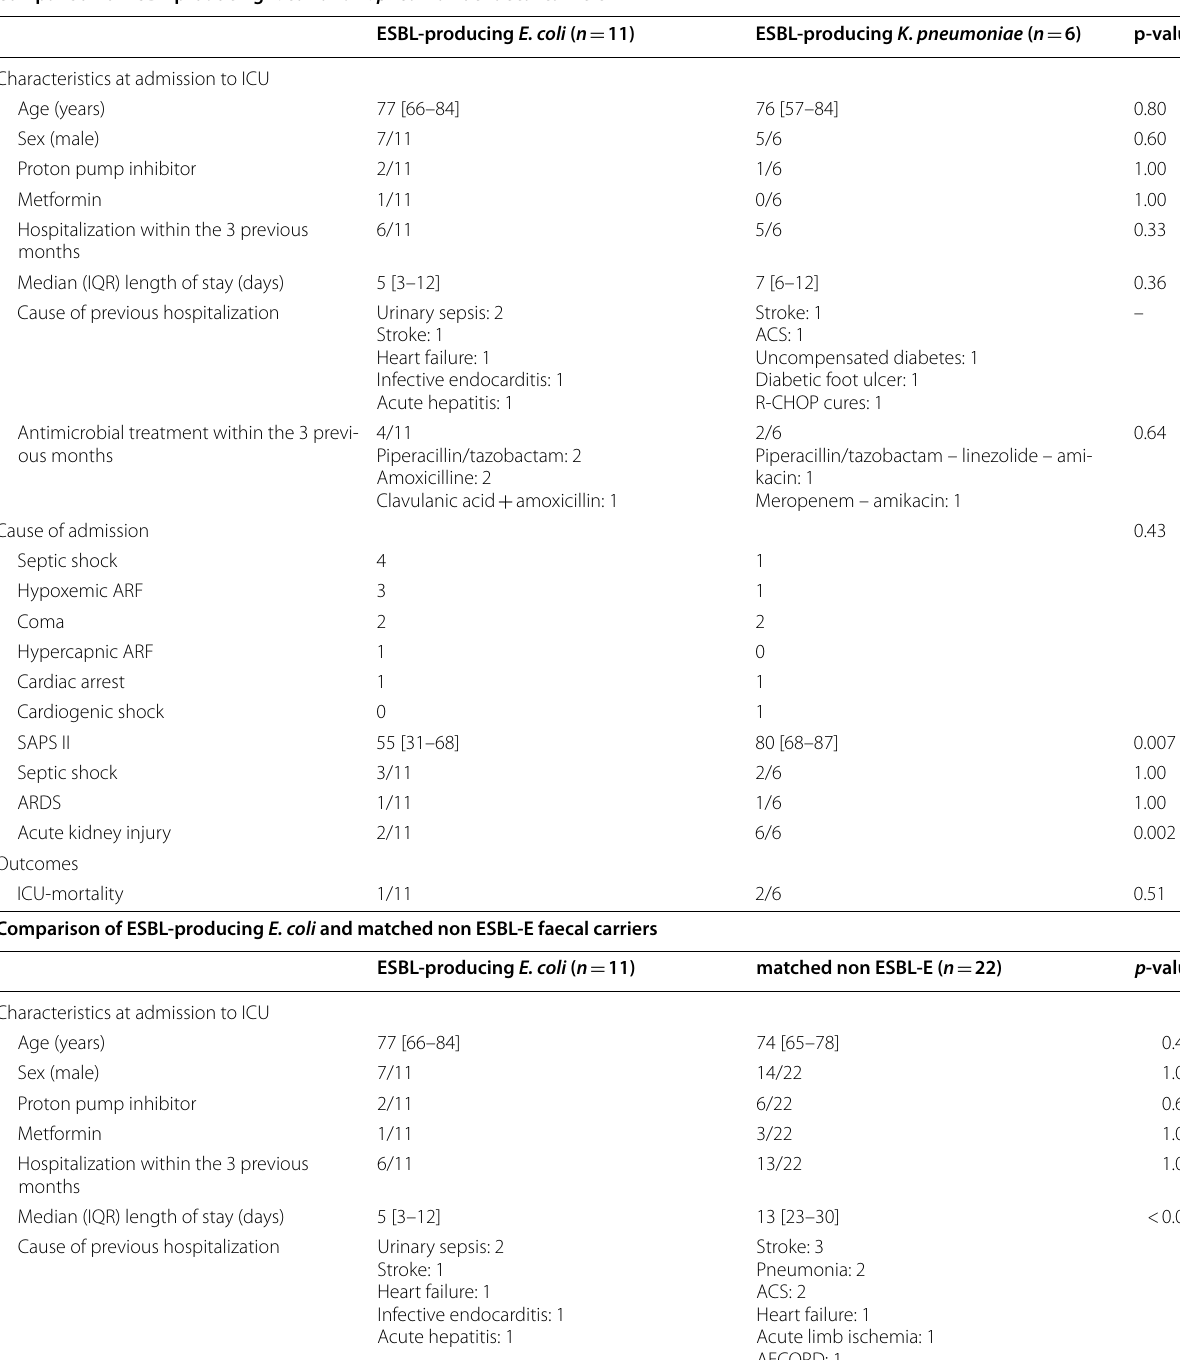
Table 1 Patients’